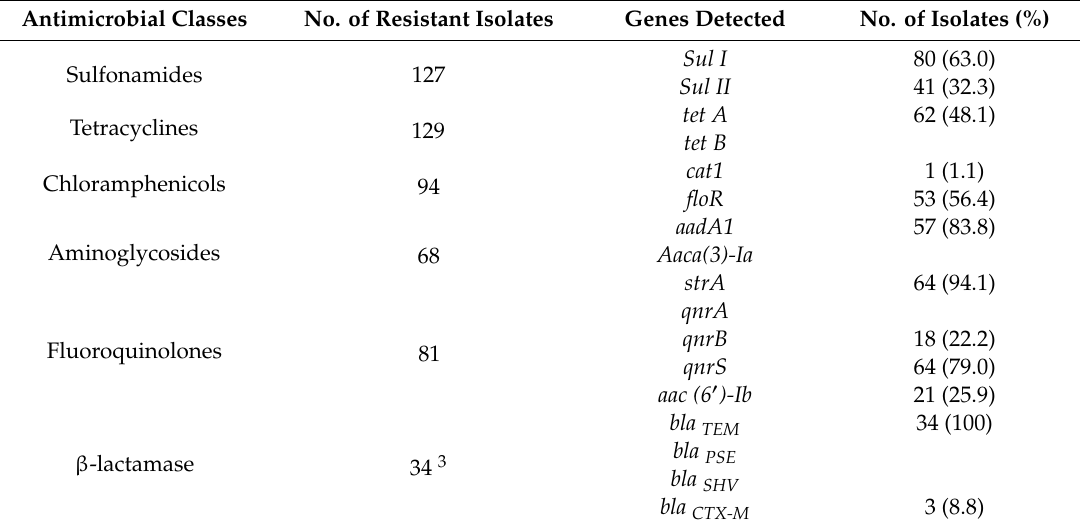
Table 4. Distribution of antibiotic resistance genes among Salmonella isolates. Antimicrobial Classes